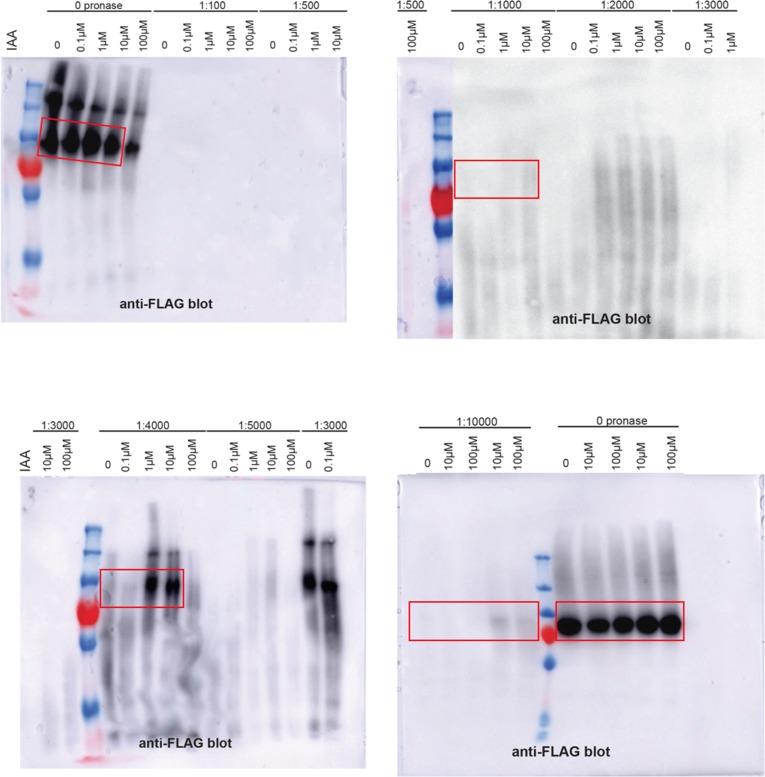
Original western blot images for DARTS assays.The red boxes indicate the regions used in Figure 1a.